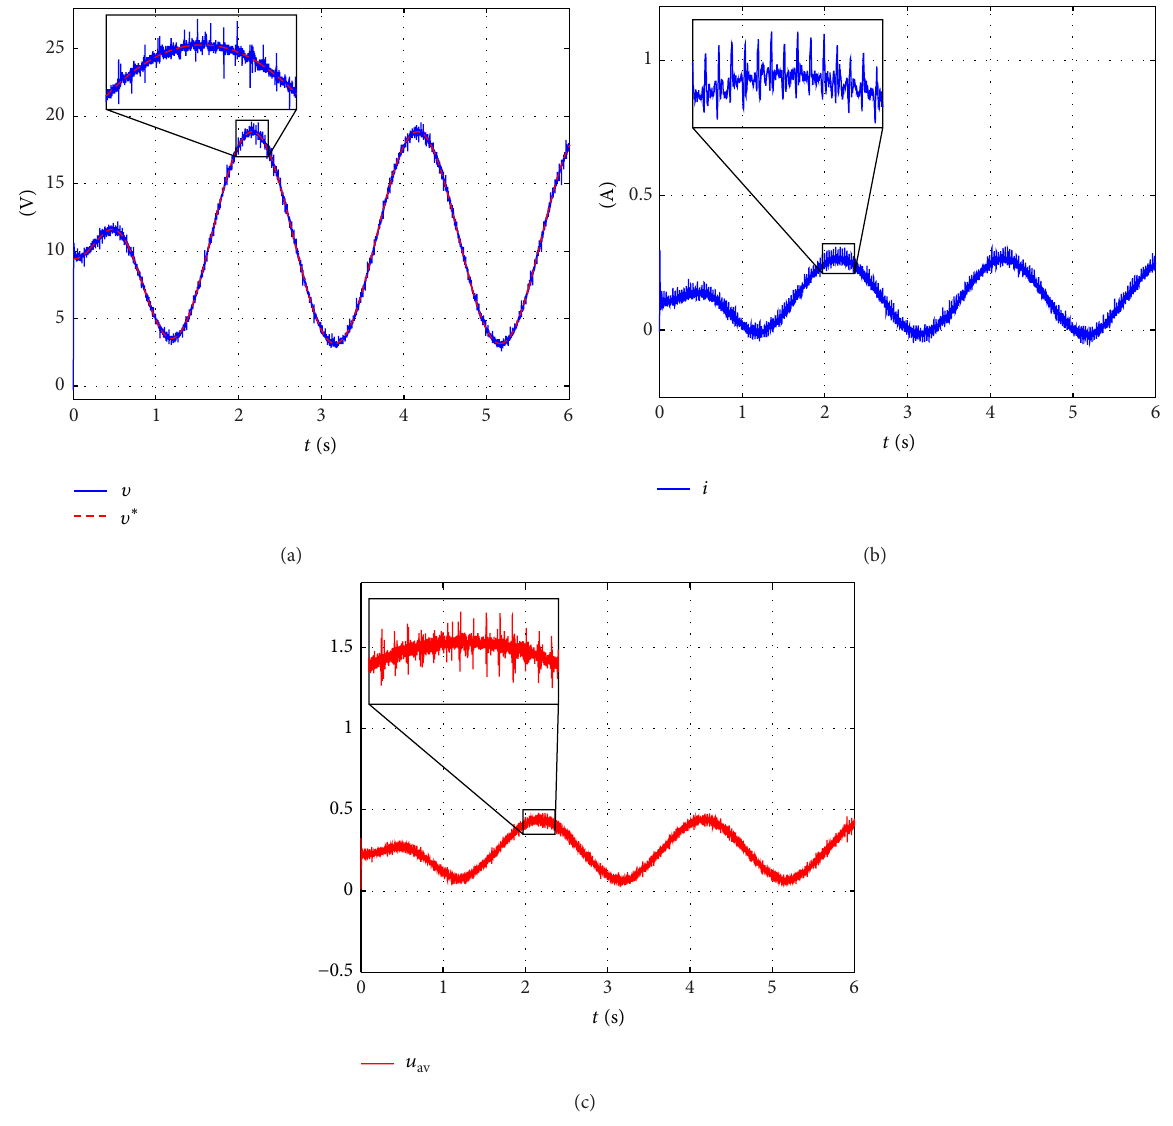
Figure 5: Case (i) via